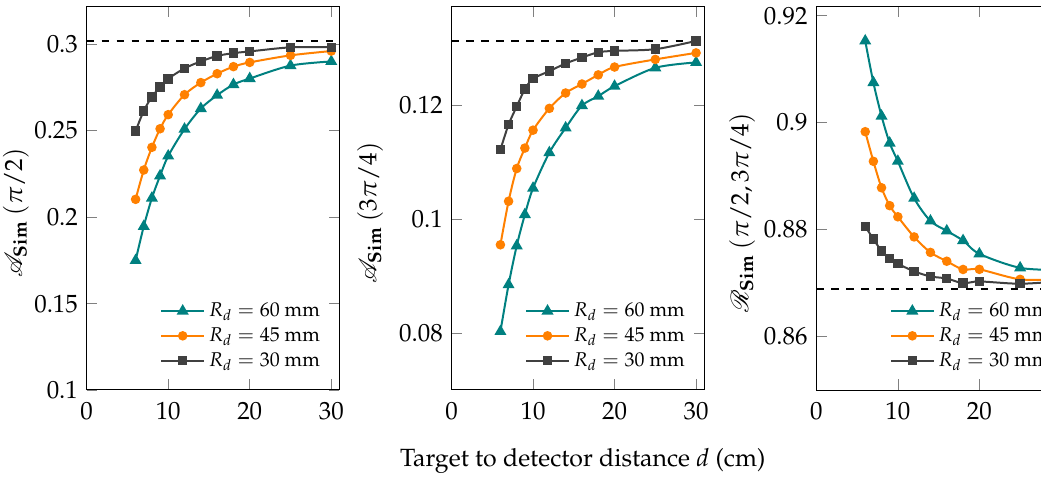
Figure 10. The same as Figure 4 for the dipole transition with a spin sequence of 5